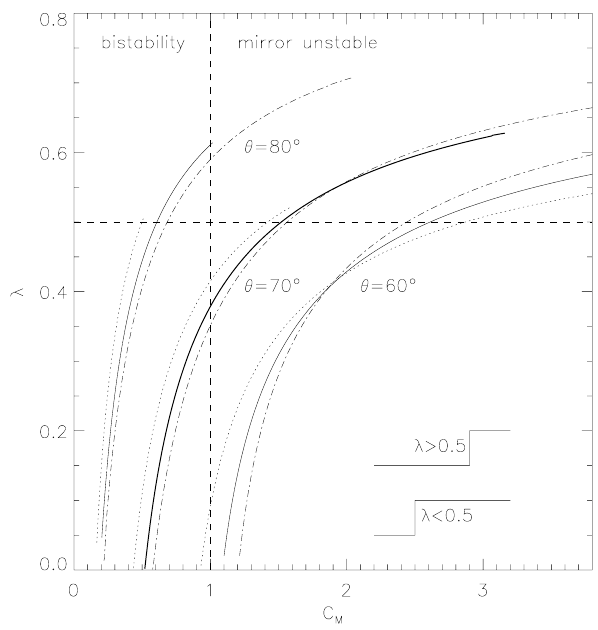
Fig. 8. Shape factor ( λ ) of the solutions of Passot et al. (2006)’s fluid model, as a function of the mirror parameter C M . As shows the insert in the lower right corner, λ< 0 . 5 corresponds to “hole” so- lutions and λ> 0 . 5 corresponds to “peak” solutions. The bistability region is in the range 0 <C M < 1. The different curves correspond to the validity domain of the solutions of the model for three θ kB and three β k values: 2 (dotted line), 4 (solid line), and 8 (dash-dotted line). For given angle and β k values the solutions of the model live in a range of temperature anisotropy, i.e in a range of C M